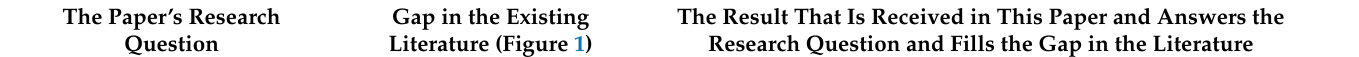
Table 6. The specified fundamental provisions of the Theory of financial risks of the green